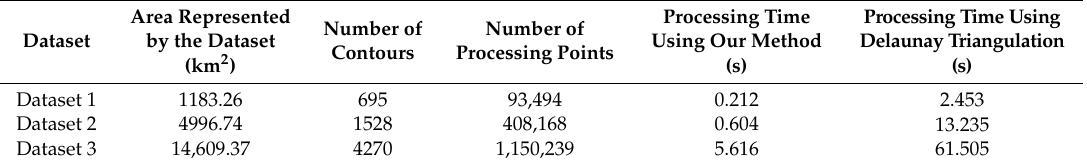
Table 1. Overview of experimental